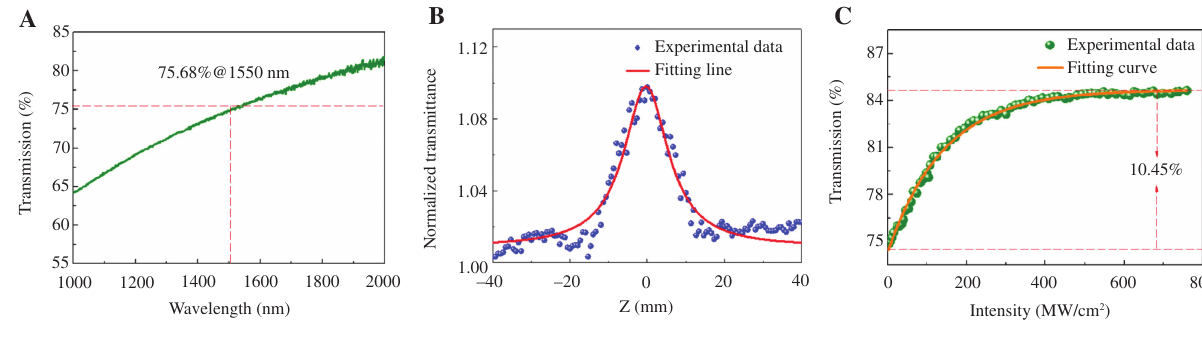
C. 2 C material. (B) The position-dependent nonlinear transmittance of the Mo 2 C/FM 2